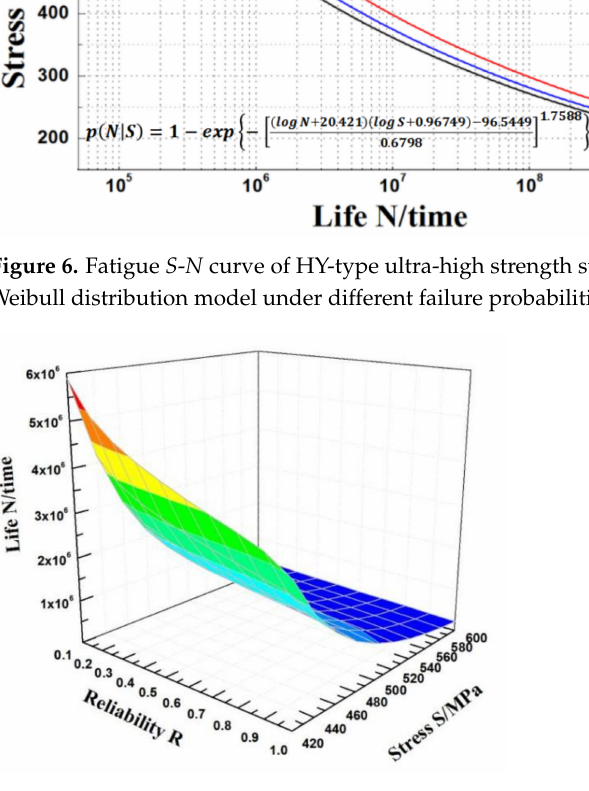
Figure 7. Variation in the fatigue life of HY-type sucker rod a function of stress and